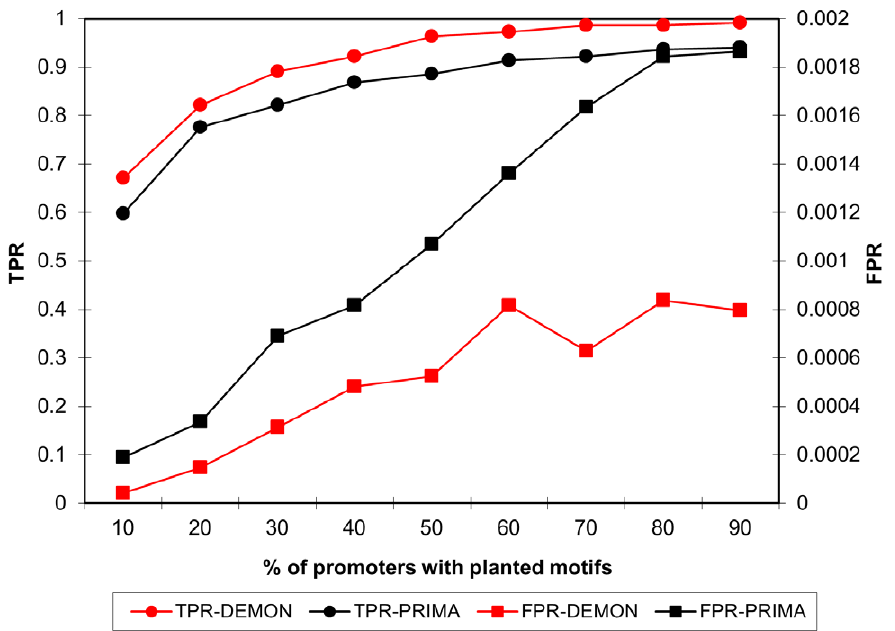
Figure 3. Results from the simulation benchmark. A comparison between DEMON’s and PRIMA’s performance on data sets with various percentage of promoters with planted motifs.